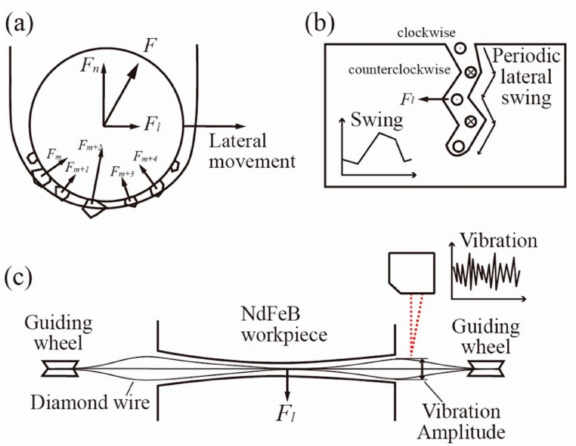
Figure 8. Illustrations of ( a ) the total force acted on the wire at a particular moment; ( b ) the formation of periodic lateral swing; ( c ) the test method and vibration amplitude at different location.